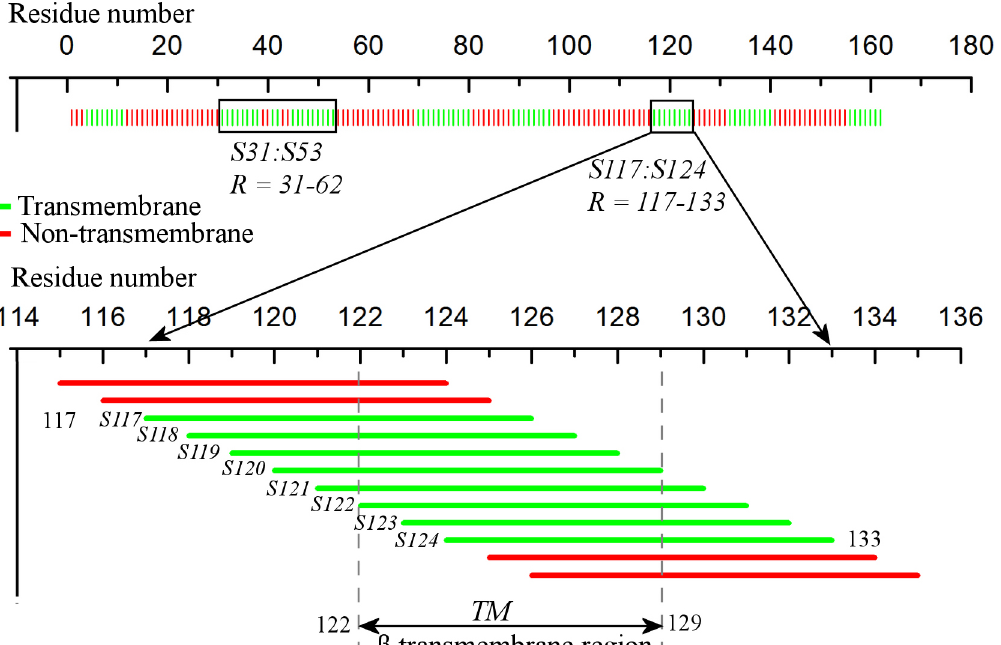
Fig 2. Prediction of transmembrane regions by the Pred β TM algorithm. a) The vertical colored bars represent the first residues of the 162 segments of the protein 1QJP. The segments in green are predicted as tm , and those in red as ntm by the β TM SVM classifier. Two stretches of consecutive tm segments are highlighted ( S31 : S53 and S117 : S124 ). (b) The tm stretch R covering residues 117 – 133 is enlarged. The constituent segments ( S117 : S124 ) are shown in their full lengths to illustrate the overlap. The reported transmembrane region ( TM = 122 – 129) is